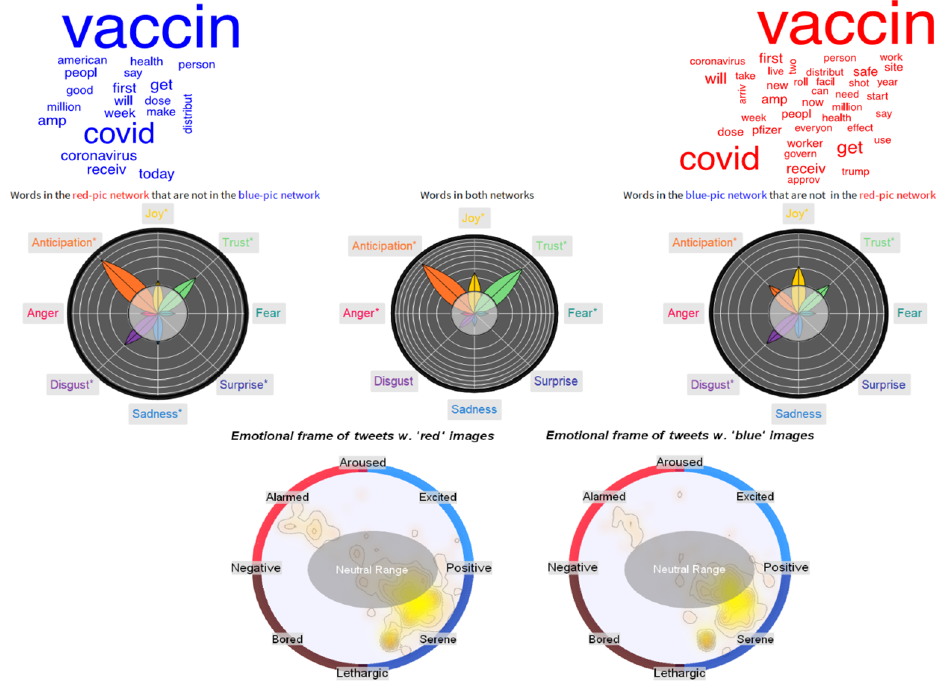
Figure A2. ( Top ): Word cloud of the most frequent words in tweets with pictures with predominant blue or red. ( Bottom ): Emotional flowers and circumplex model for the emotions of the language used in tweets with pics of different predominant colours. Asterisks highlight emotions z > 1.96.